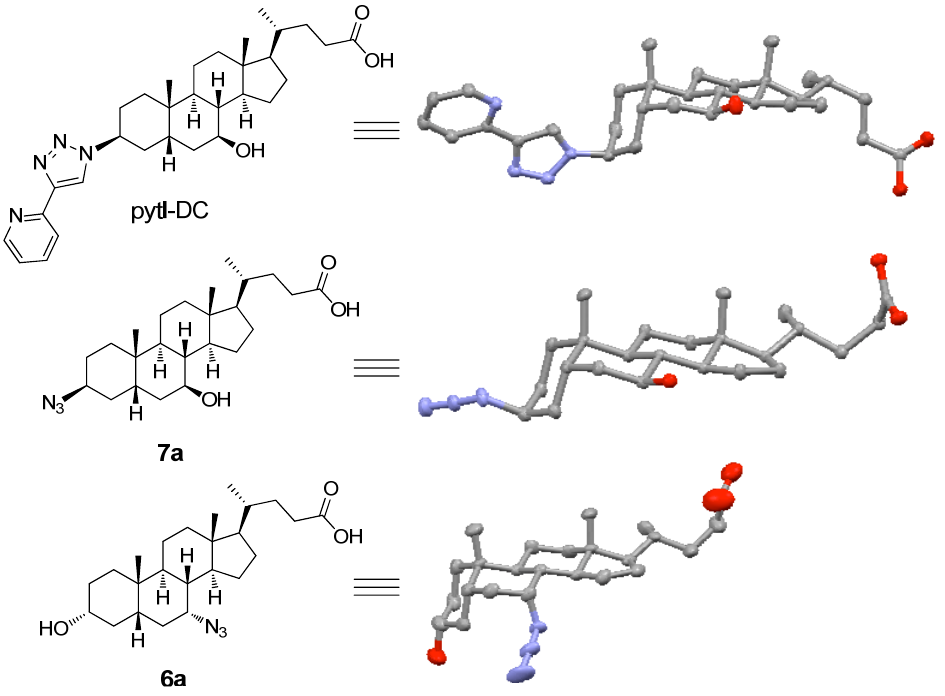
Figure 1. Crystal structures of pytl-DC, 6a and 7a . Gray, carbon; blue, nitrogen; red, oxygen. The thermal ellipsoids for the image represent 25% probability limit. Hydrogen atoms are omitted for